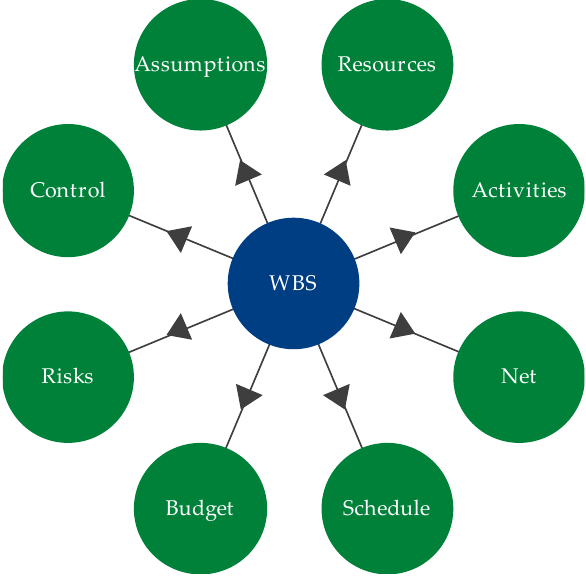
Figure 1. Relationship of the work breakdown structure (WBS) with the project.